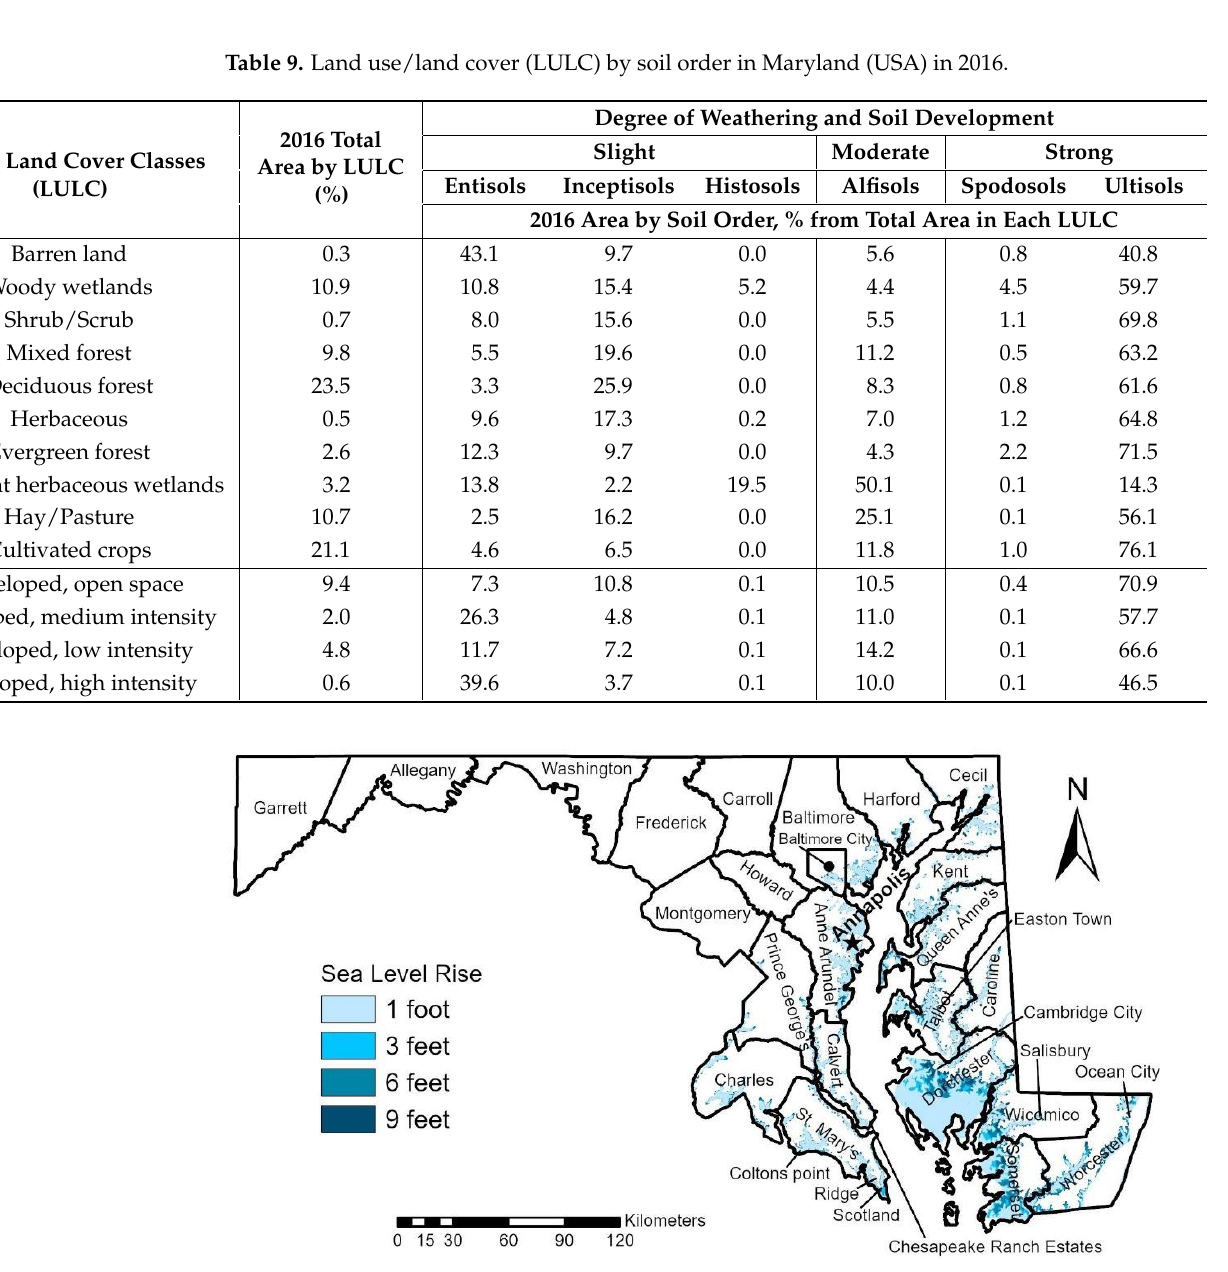
Figure 5. Projections of possible, future, sea level rise associated with climate change in Maryland (USA), which may have an impact on 17 out of 23 Maryland’s counties with Dorchester, Wicomico, and Queen Anne’s counties experiencing the most dramatic land losses. Table 10. Potential loss of county area (%) from sea level rise in Maryland, USA (from an original